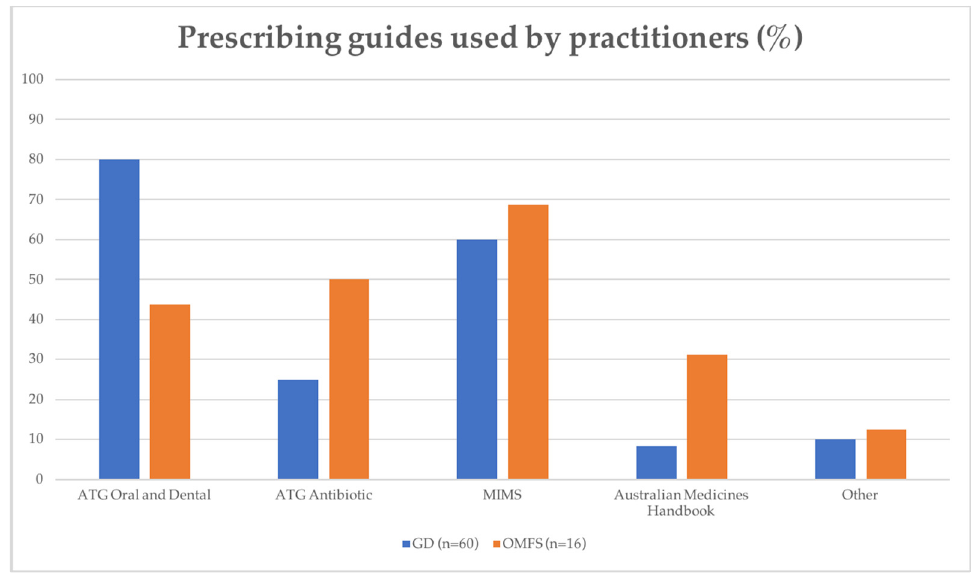
Figure 2. Percentage (%) use of prescribing guides within GD ( n = 60) and OMFS ( n = 16) groups.